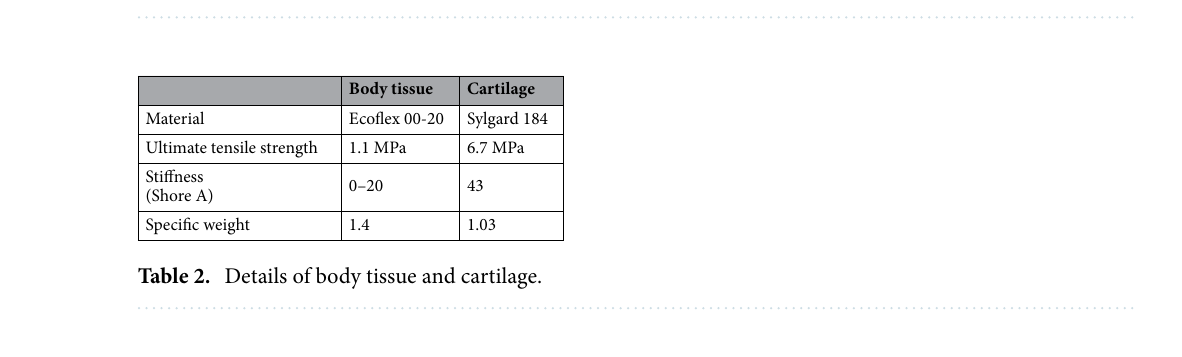
Table 1. Summary of peak speed, electric power, and the corresponding driving frequency for the swimming tests.